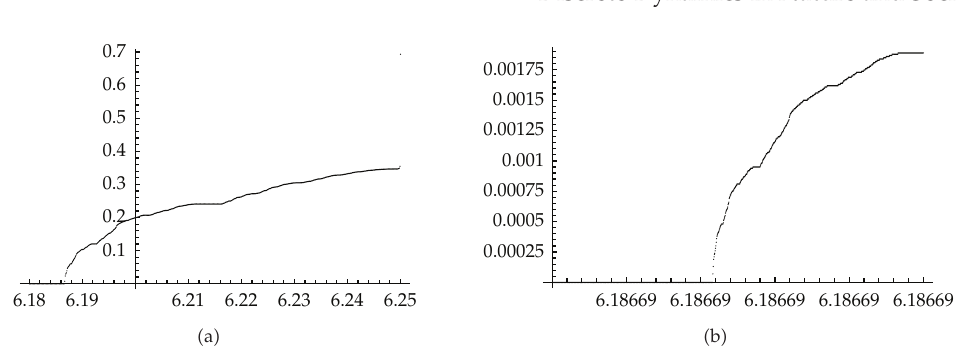
Figure 2: Topological entropy of the map g a . (cid:4) a (cid:5) We can find the entropy for a ∈ (cid:2) 6 . 18 , 6 . 25 (cid:3) with accuracy of 10 − 3 . (cid:4) b (cid:5) We can see a zoom close to a (cid:6) 6 . 186, when the topological entropy becomes to be positive. The accuracy for the right picture is 10 − 5